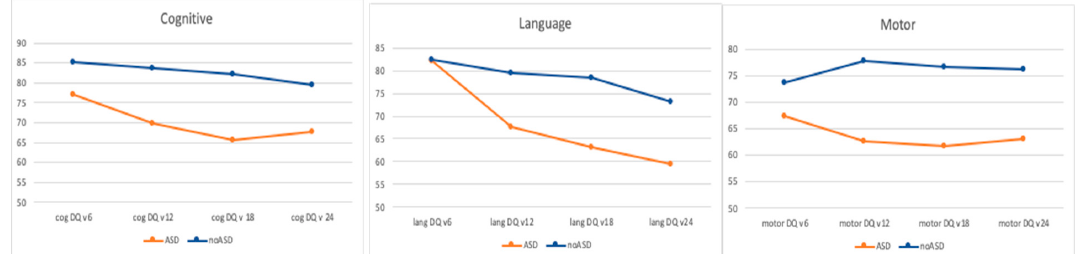
Figure 1. Developmental trajectories of children with (orange line) and without (blue line) ASD in the three areas explored by BSID. Differences are evident already at six months of age both in cognitive and motor areas; thereafter there is a clearer differentiation of neurodevelopmental skill acquisitions. Cog DQ: cognitive developmental quotient; lang DQ: language developmental quotient.